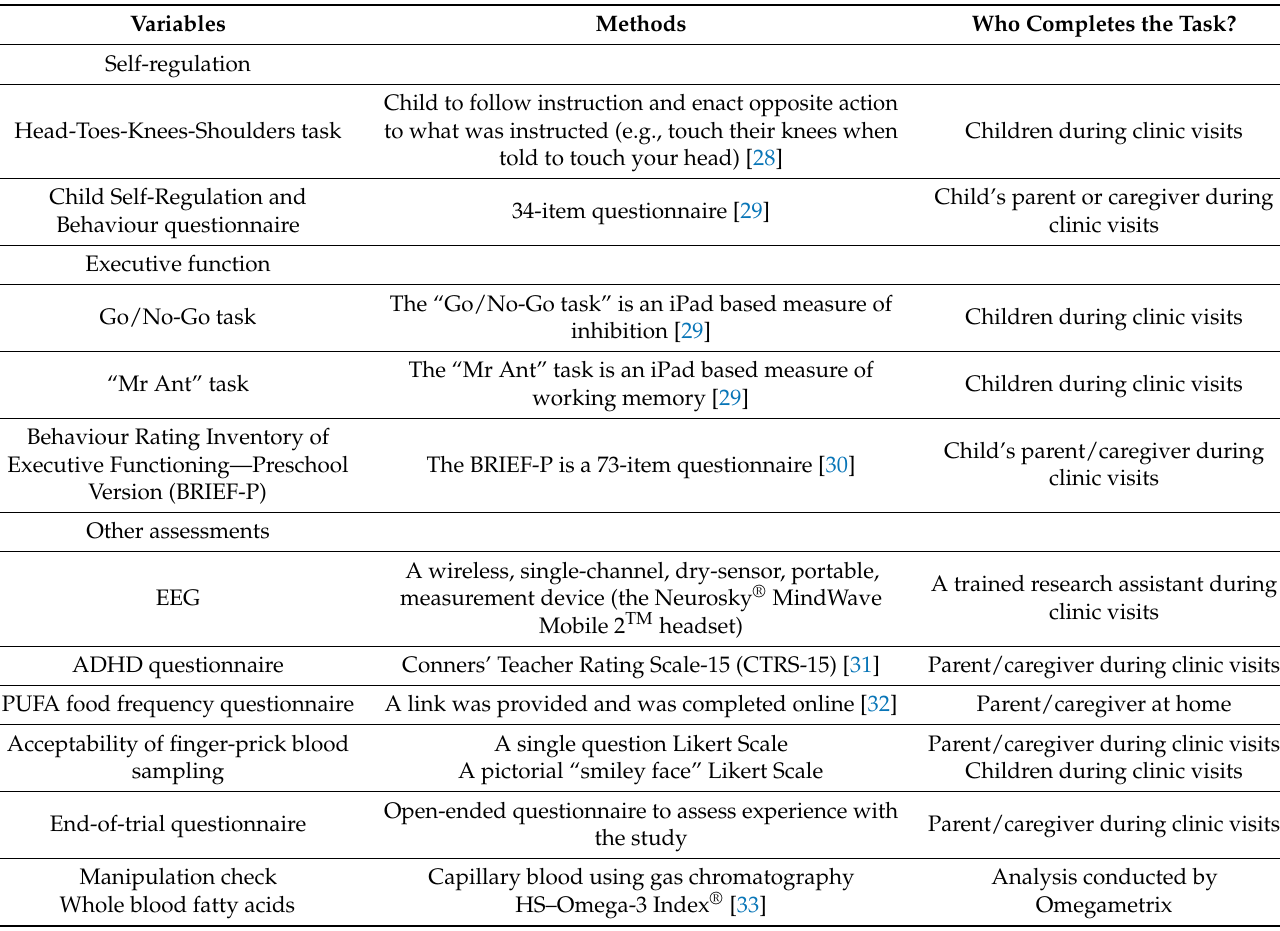
Table 1. Summary of the study outcome measures and